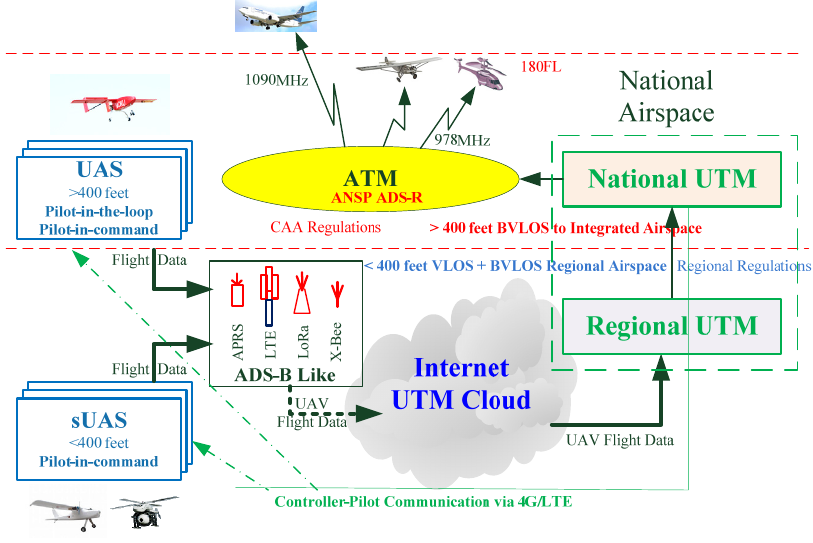
Figure 4. The hierarchical UTM in Taiwan.